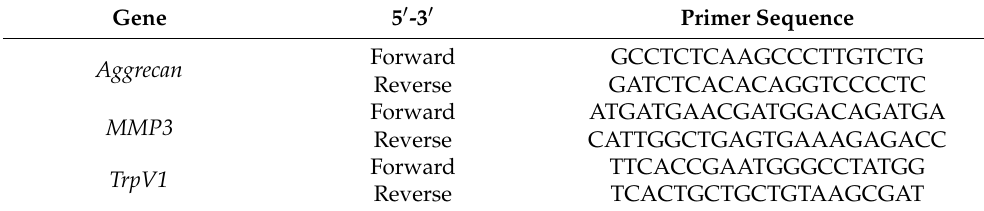
Table 1. Primer sequences used for real-time PCR analysis.